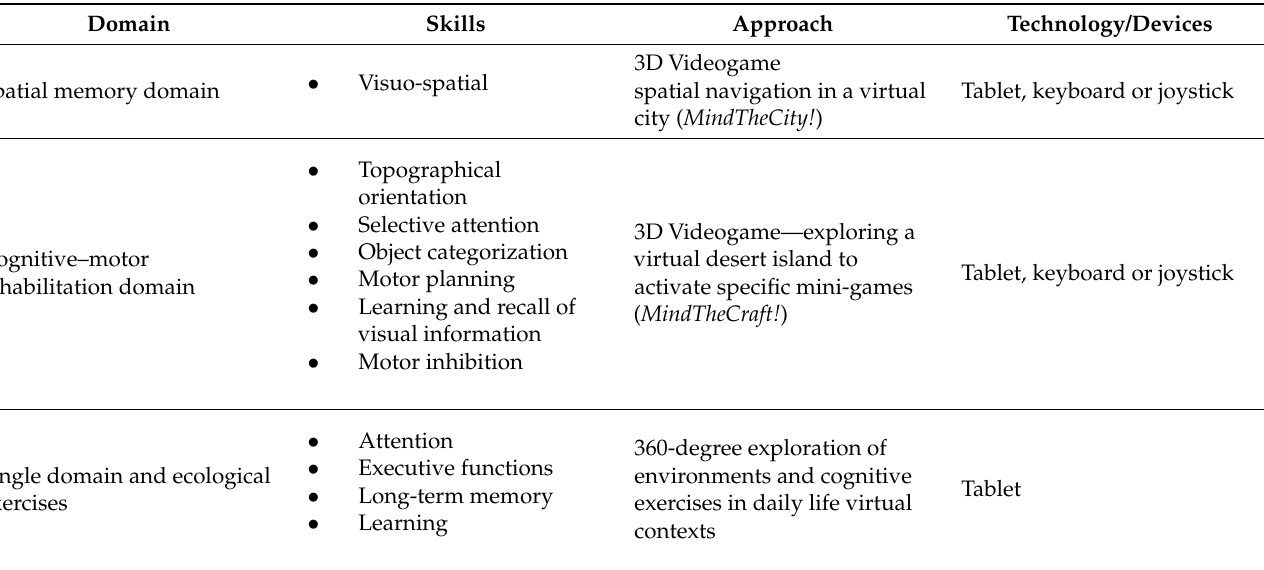
Table 1. Summary of the main functionalities of the